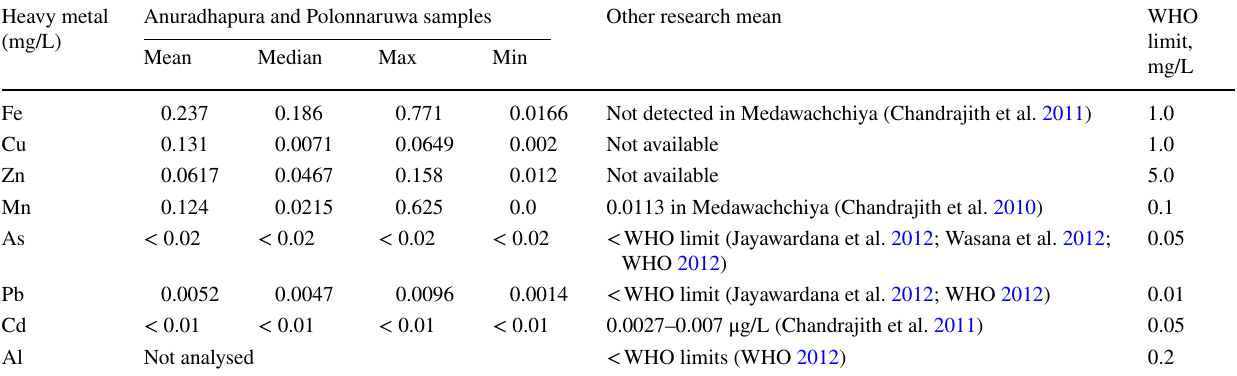
Table 14 Heavy metal analytical results in CKD endemic areas Heavy metal Anuradhapura and Polonnaruwa samples Other research (mg/L)